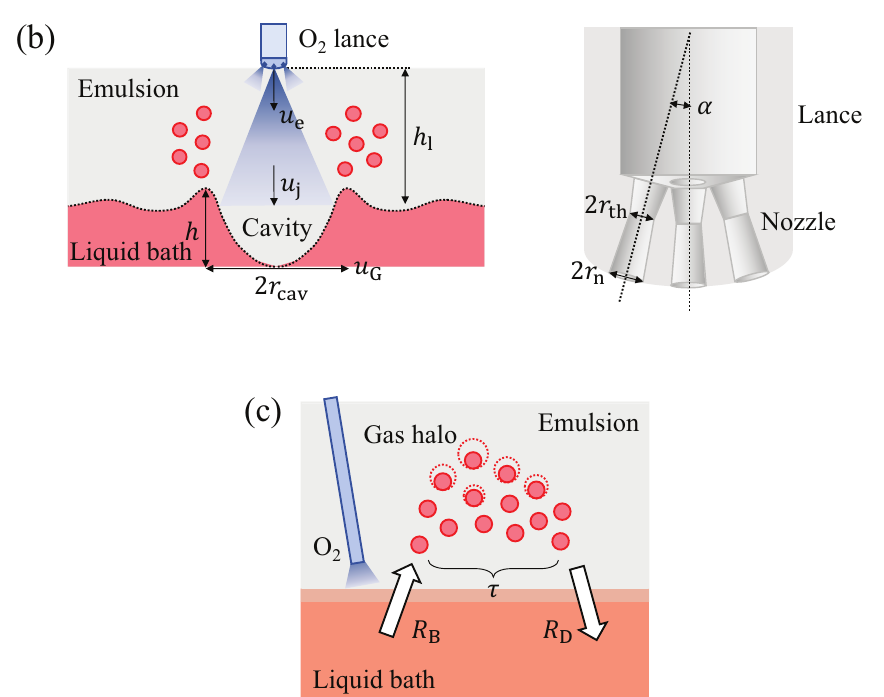
Figure 5. A schematic diagram of evaporation during the BOF process: ( a ) converter showing various places of evaporation ( D = 6.7 m): A ED , A IZ , and A LB are the surface areas of the ejected droplets, the impact zone forming the cavity, and rest of the surface of liquid bath, respectively; ( b ) nozzle configuration and cavity formation: h , h l , r cav , u e , u j , and u G are the cavity height, the lance height, the radius of the cavity, the jet centerline velocity at nozzle exit, the jet centerline velocity at impact point, the critical tangential jet velocity, respectively; ( c ) droplet generation beneath the nozzle: R B , R D , and τ are the specific droplet generation rate, the specific droplet removal rate, and the residence time of the droplet, respectively.